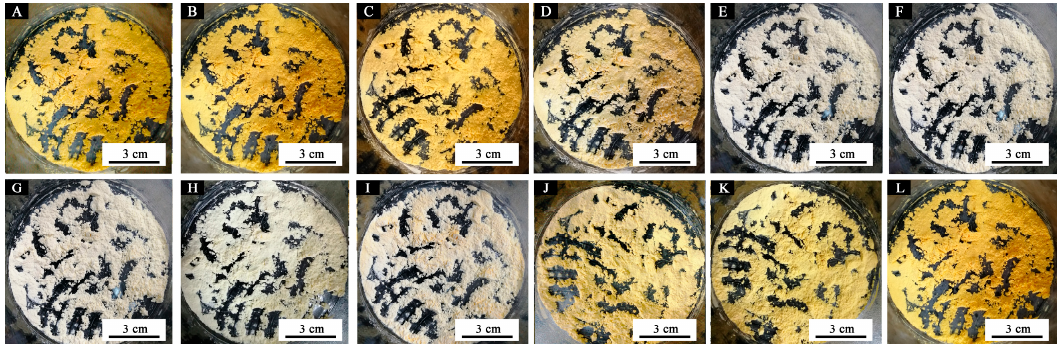
Figure 7. Color trend of thermochromic microcapsules changes with temperature: temperature increases to ( A ) 16 °C; ( B ) 26 °C; ( C ) 28 °C; ( D ) 30 °C; ( E ) 32 °C; ( F ) 40 °C; temperature drops to ( G ) 40 °C; ( H ) 32 °C; ( I ) 30 °C; ( J ) 28 °C; ( K ) 26 °C; ( L ) 16 °C.